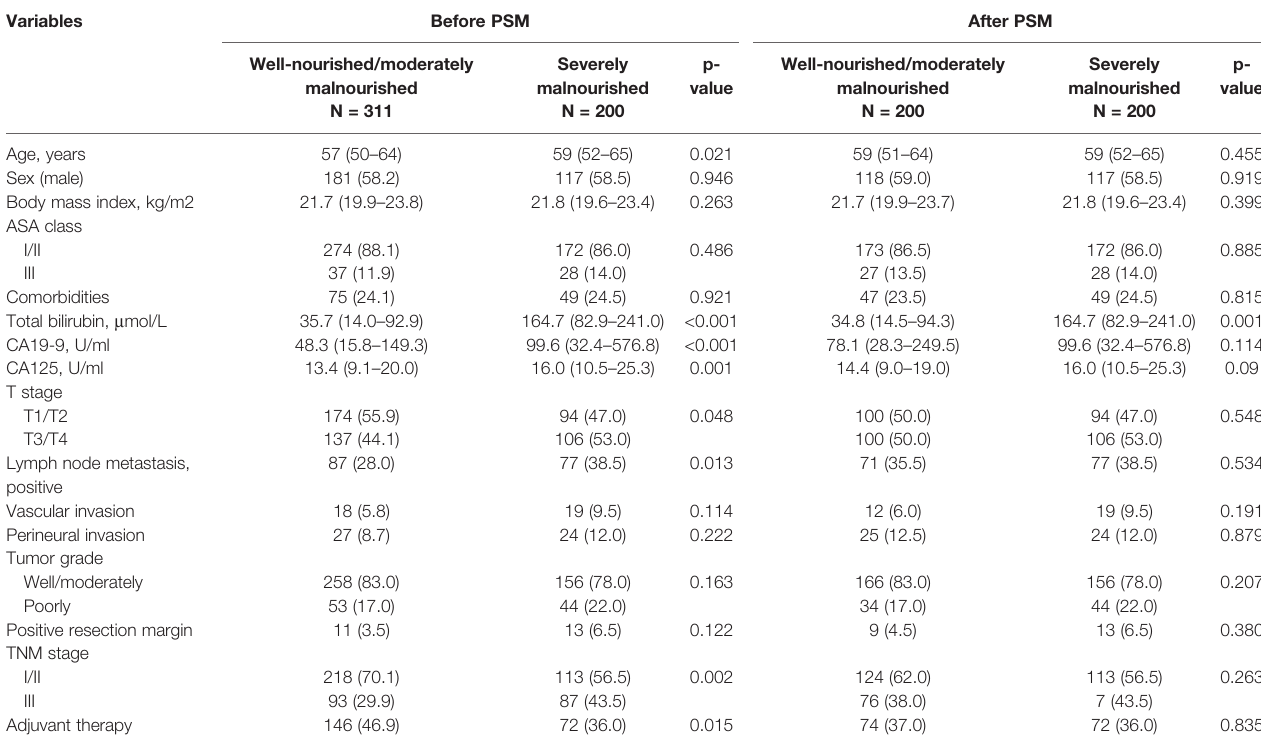
TABLE 2 | The relationships between preoperative nutritional status and clinicopathological characteristics in 511 patients underwent pancreatoduodenectomy for ampullary carcinoma after PSM. Variables Before PSM After PSM Well-nourished/moderately Severely p- Well-nourished/moderately Severely p- malnourished malnourished value malnourished malnourished value N = 311 N = 200 N = 200 N = 200 Age, years 57 (50 – 64)